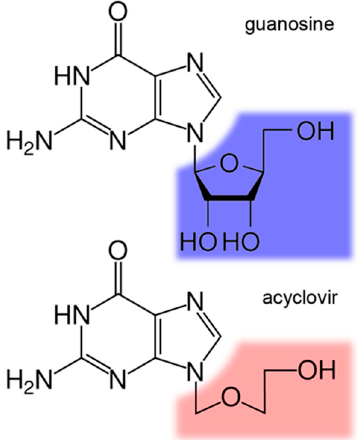
Figure A1. Structural correlation between guanosine and acyclovir.